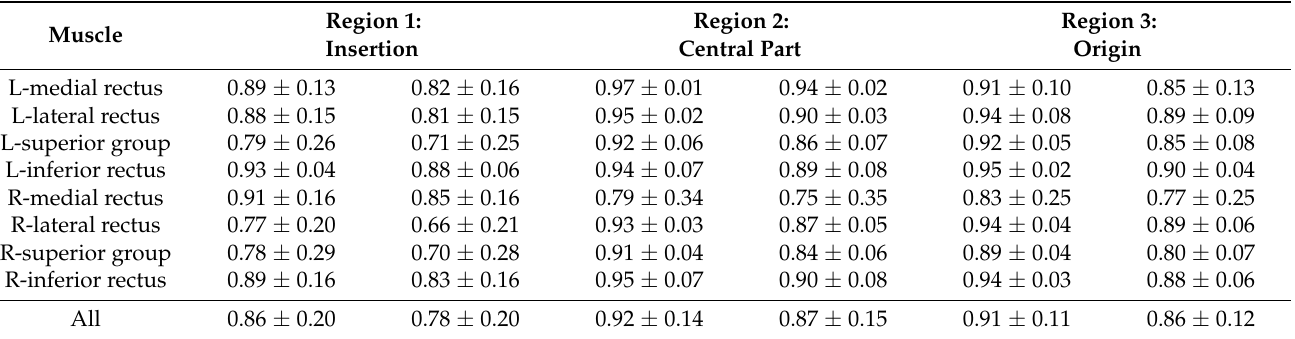
Table 4. Performance of selected U-net on test data split by extraocular muscle regions (near insertion, muscle belly, and near origin).